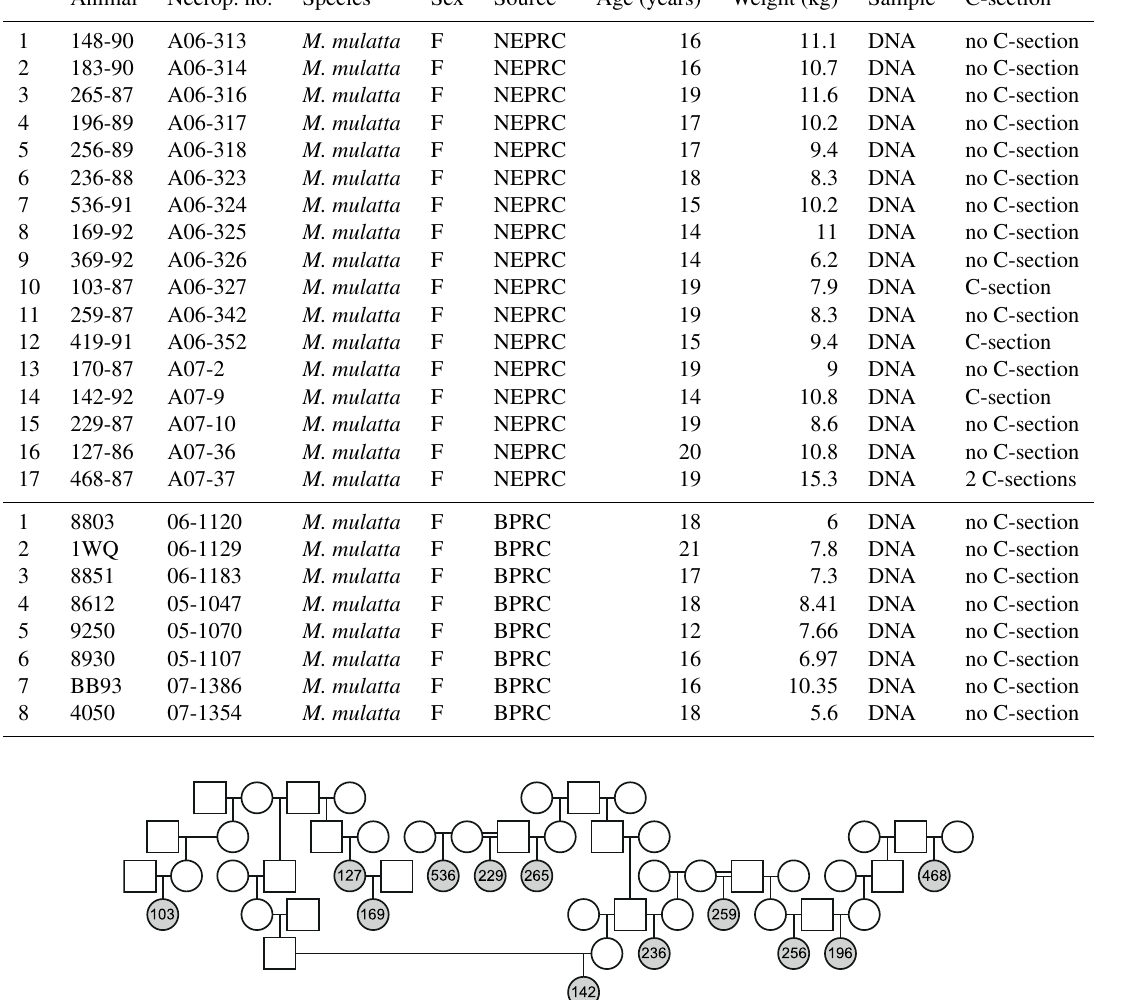
Figure 4. Pedigree showing the familial relationships of 12 of the 17 animals from the NEPRC colony. Legend: females are represented by circles and males by squares. Animals diagnosed with endometriosis are shaded in